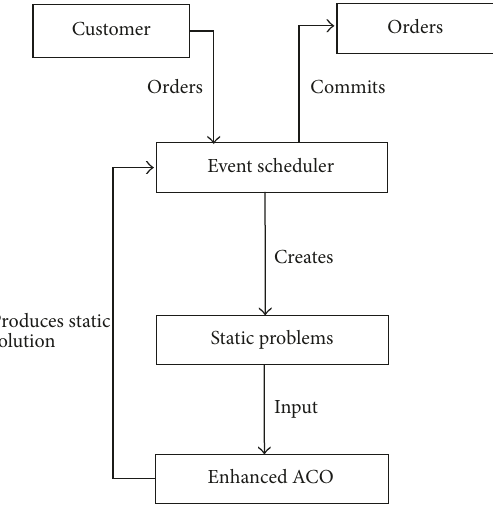
Figure 2: The flow chart of event scheduler.